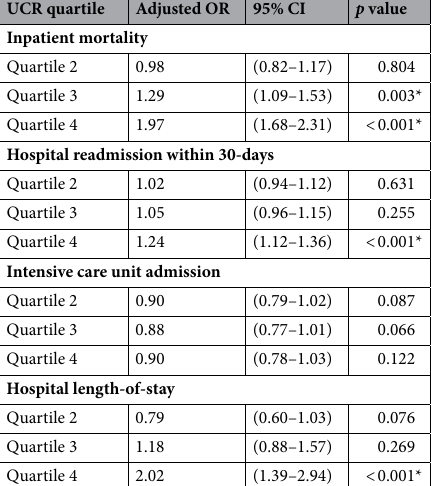
UCR quartile Adjusted OR 95% CI p